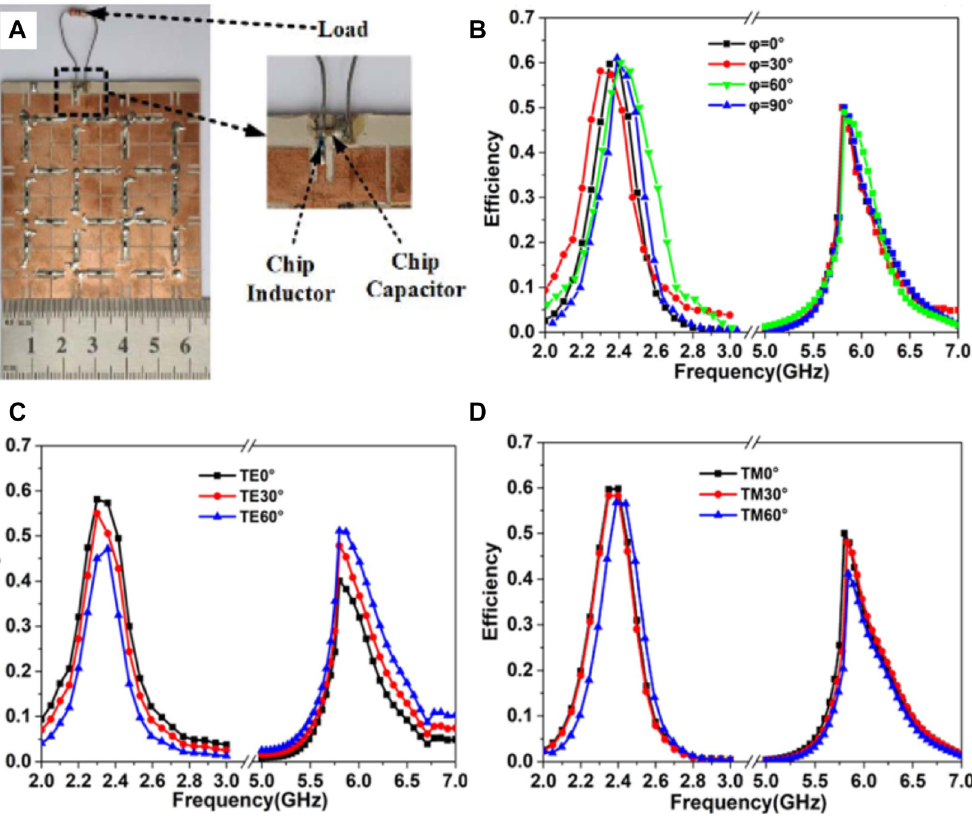
Figure 15: Rectifying metasurface (RMS) for WEH. (A)Dual-frequencyandpolarization-angle-independentrectifyingmetasurface.(B)-(D)Themeasuredefficiencyfordifferentpolarizationanglesunder normal incidence, TE-polarized, TM-polarized oblique incidence, respectively [101]. Reprinted from [101], with the permission of IEEE Publishing.